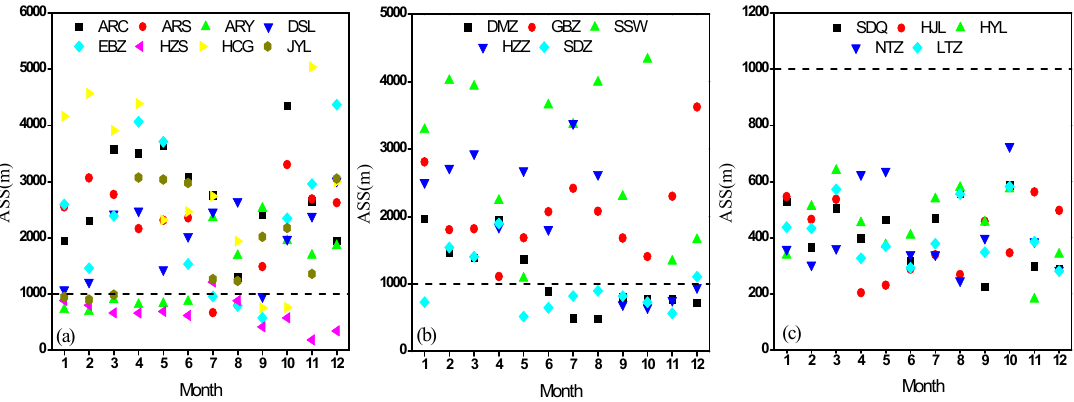
Figure 7. Monthly average structure scale (ASS) of the stations. ( a ), ( b ) and ( c ) respectively show the monthly ASS of the stations in the upstream, midstream and downstream of the HRB.